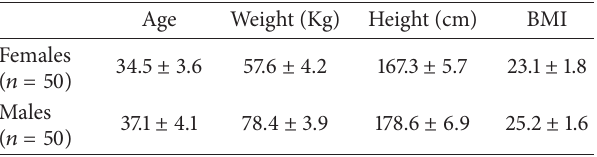
Table 1: Patients’ baseline average